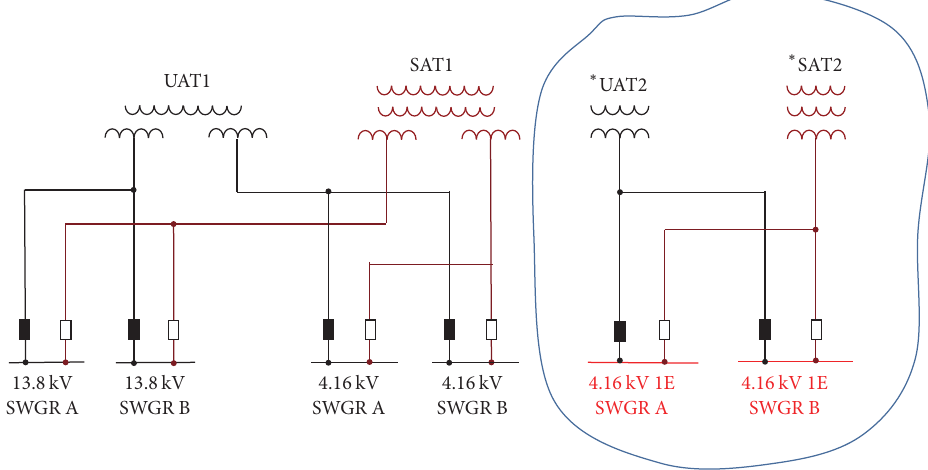
Figure 4: UAT and SAT separation for safety loads. ∗ For safety loads.